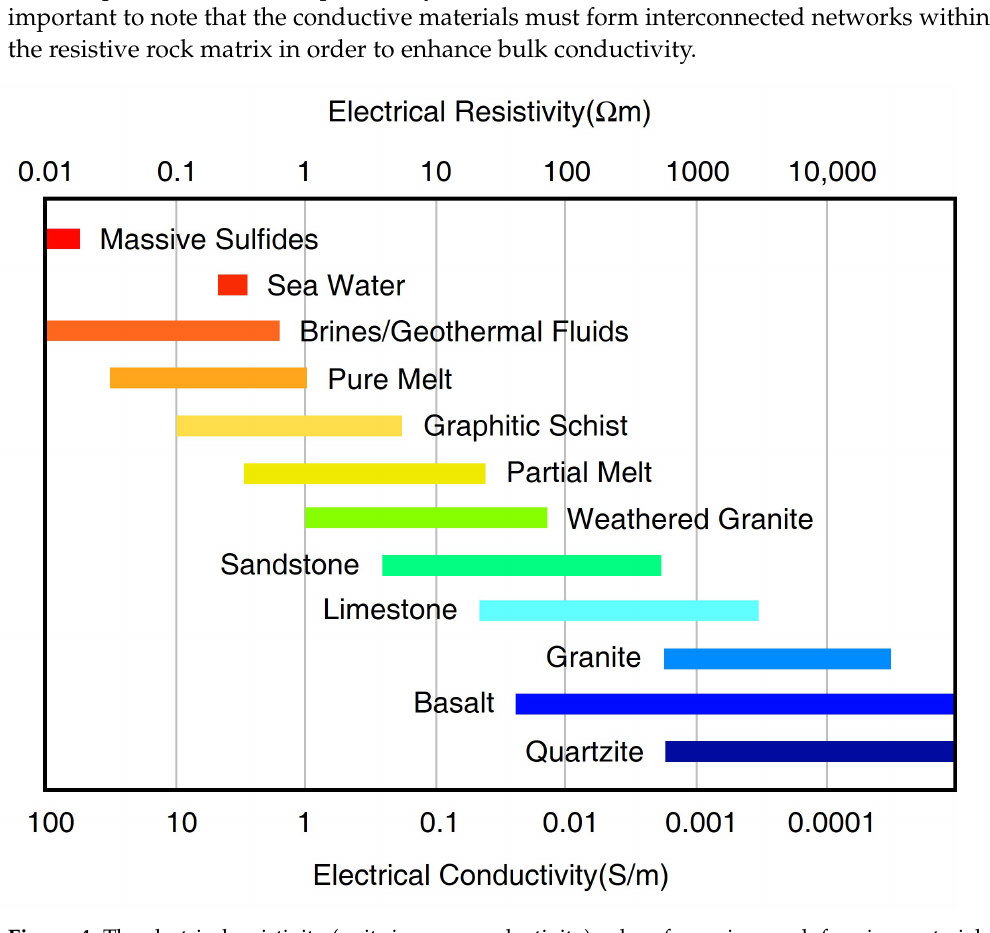
Figure 4. The electrical resistivity (or its inverse conductivity) values for various rock-forming materials by Comeau [85]; the values were taken from Simpson and Bahr [1] and references